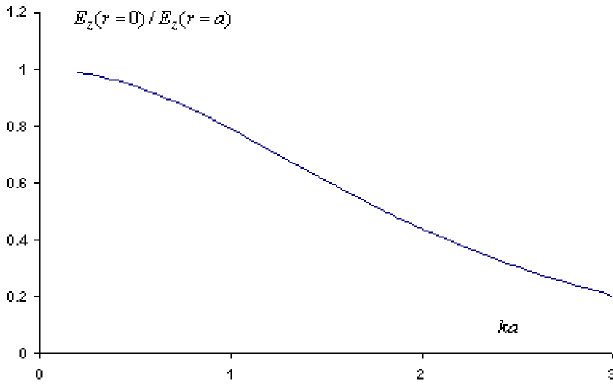
FIG. 23. (Color) Axial electric field on axis divided by the axial electric field at the helix vs ka